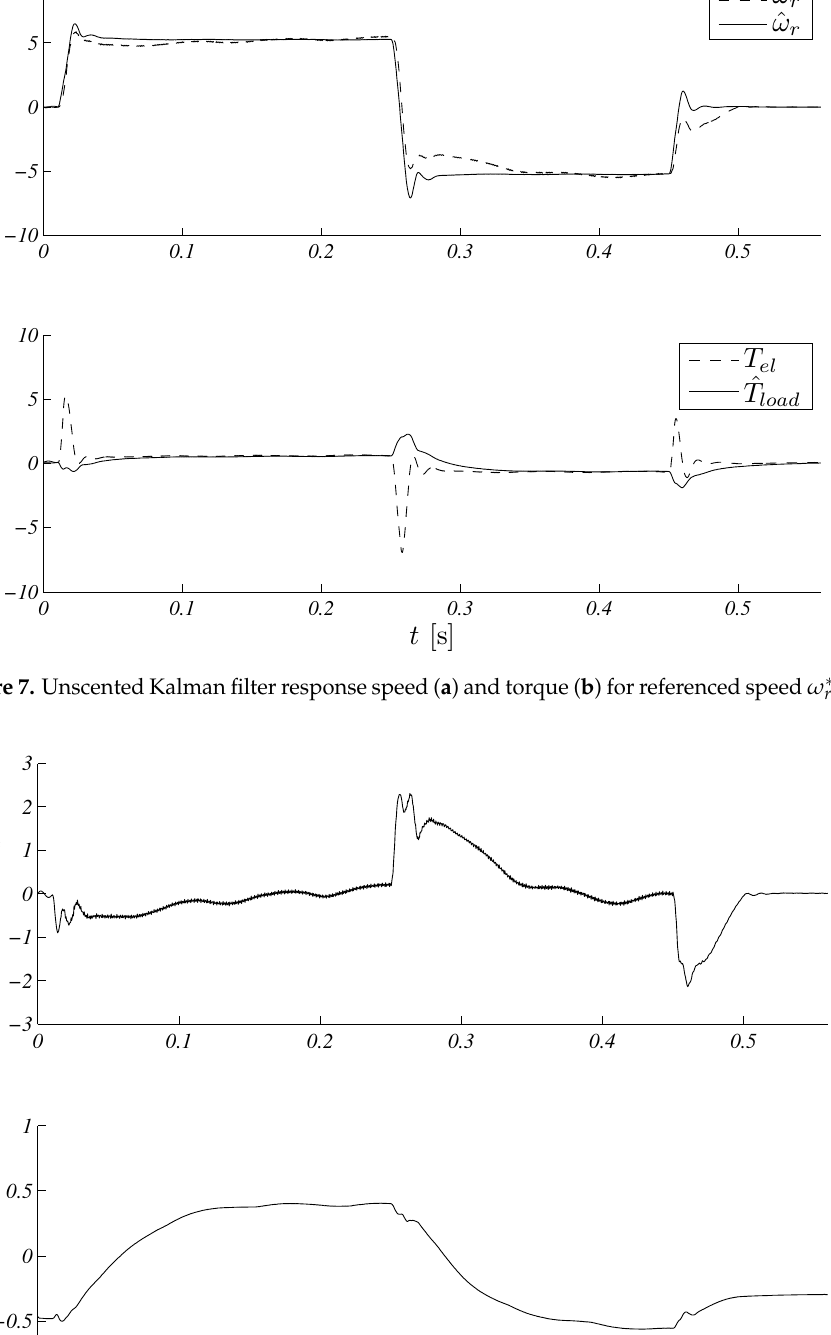
Figure 8. Unscented Kalman filter estimation speed ( a ) and torque ( b ) errors for reference speed ω ∗ r = 5.28 rad s